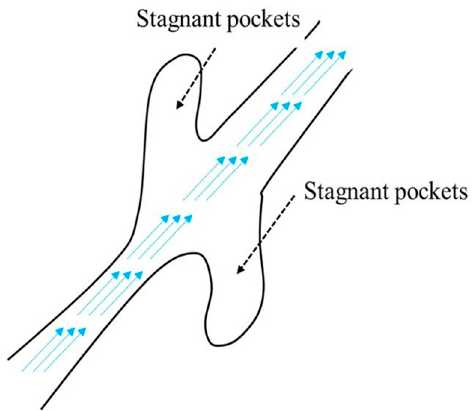
Figure 4. Schematic representation of stagnant pocket pores in a porous medium. Based on Ref. [17].